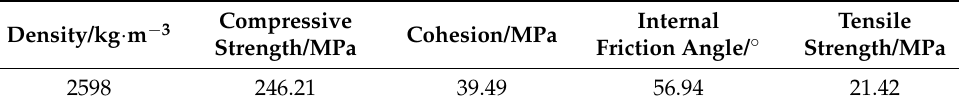
Figure 2. Internal structure of confining pressure system. Table 1. Mechanical parameters of the granite.